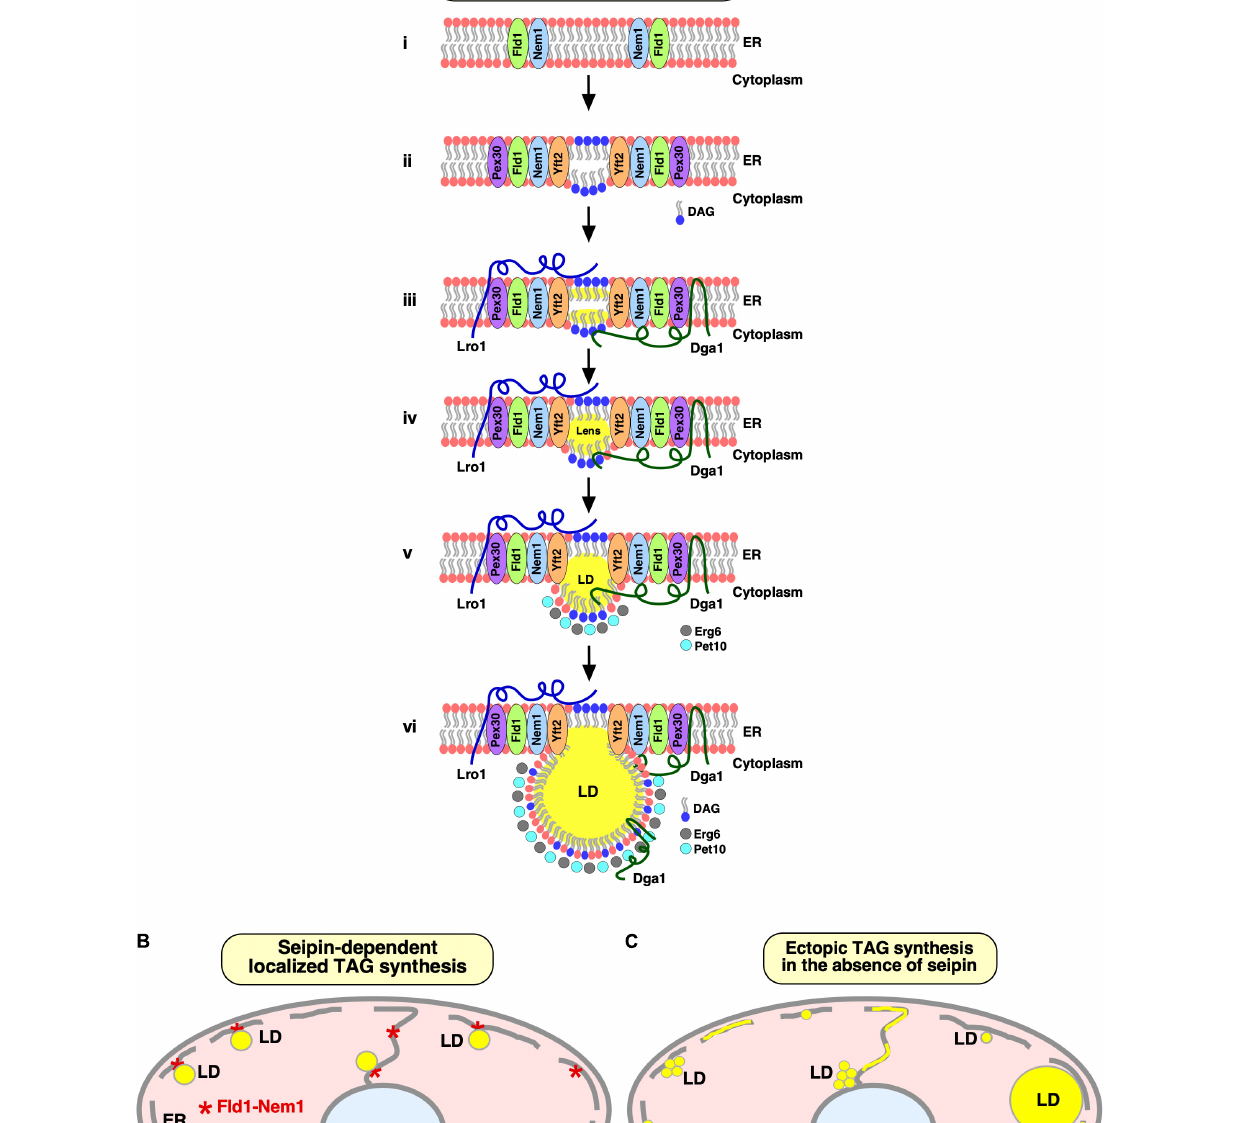
Frontiers in Cell and Developmental Biology |